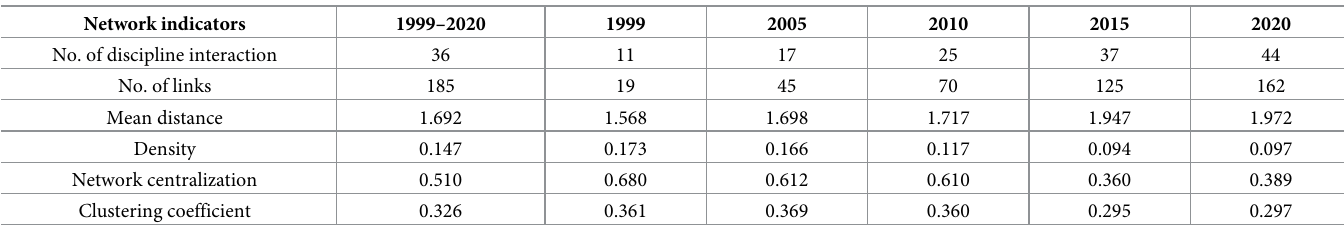
Table 2. The structure characteristics of disciplinary interaction networks.